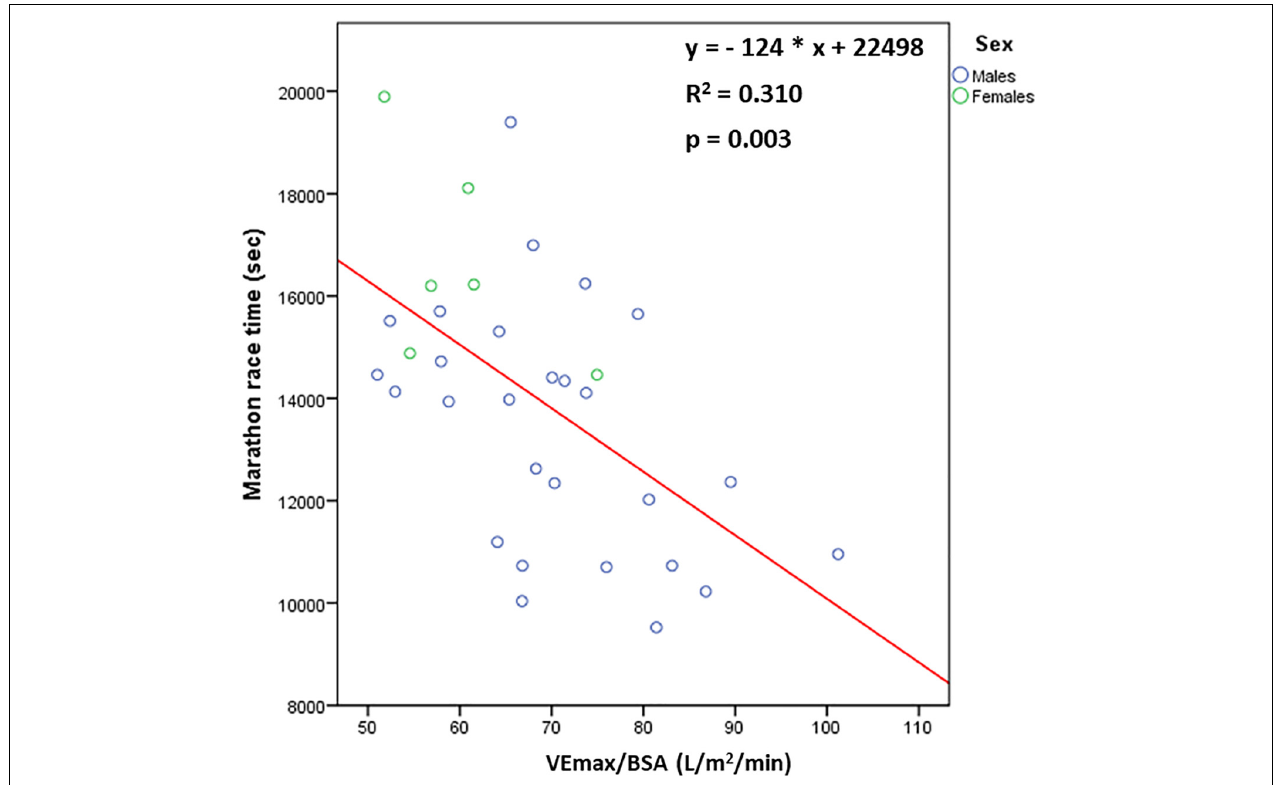
FIGURE 3 | The relationship [ n = 33 (27 males, 6 females)] between marathon race time and maximum minute ventilation indexed to body surface area